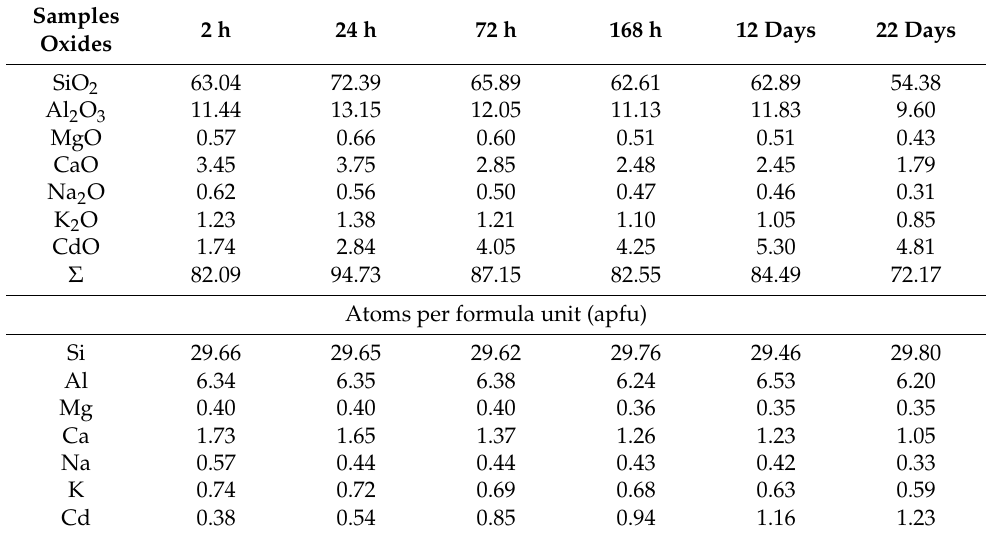
Table 1. Chemical composition (EDS, wt%) and structural formulae of Cd-clinoptilolite (RT) based on 72 oxygen atoms.